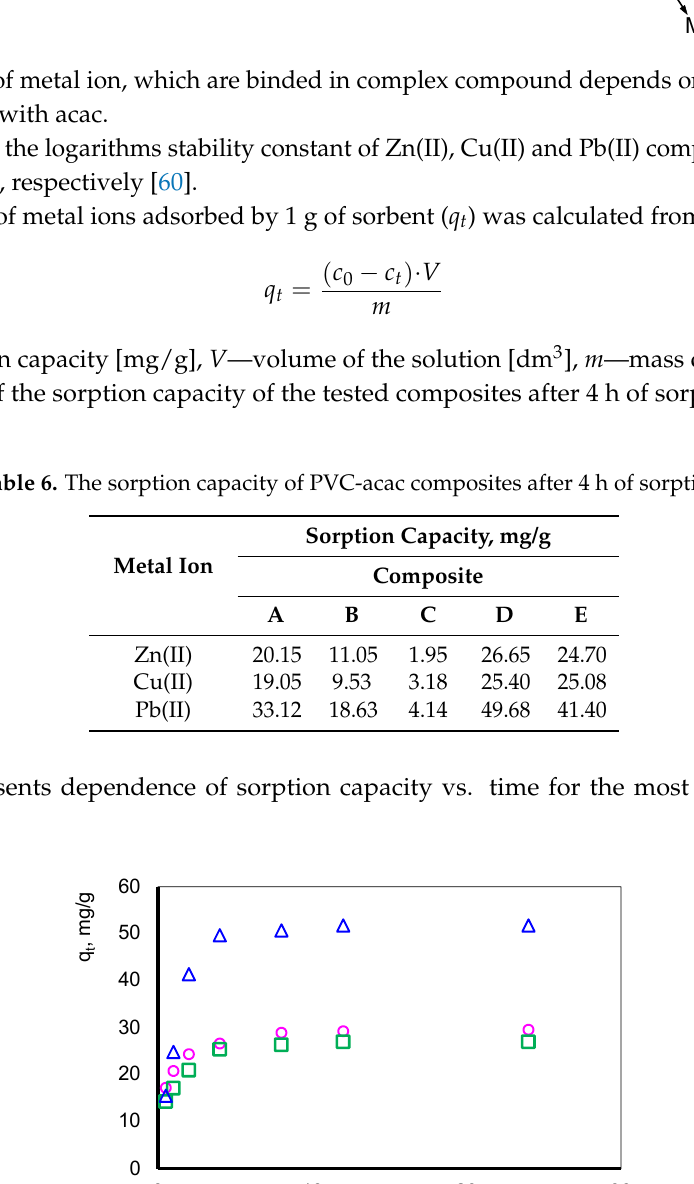
Figure 4. Sorption capacity of composite D vs. time for Zn(II) (o), Cu(II) ( □ ) and Pb(II) ( ∆ ) ions.